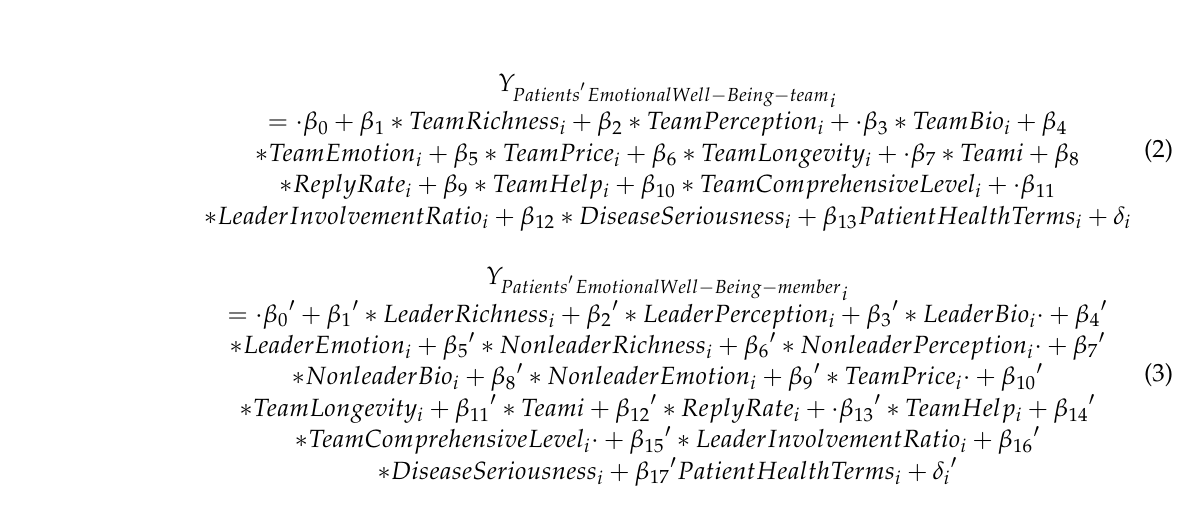
Table 4. Variable definition